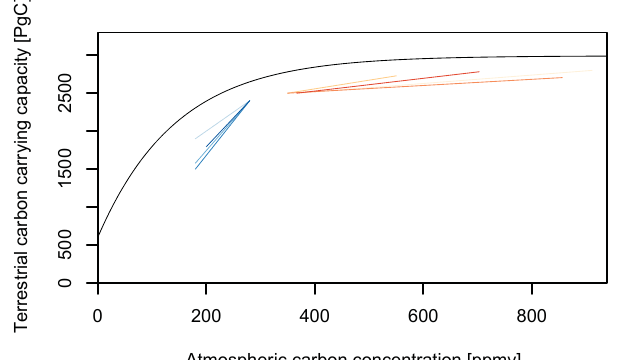
Figure 4. Approximated terrestrial carbon carrying capacity (black line). Blue lines represent approximate changes in terrestrial carbon storage published in Crowley (1995), François et al. (1998), Kaplan et al. (2002) and Joos et al. (2004). Red lines represent simulated changes in terrestrial carbon storage due to climate change reported by Joos et al. (2001), Lucht et al. (2006) and Friend et al.